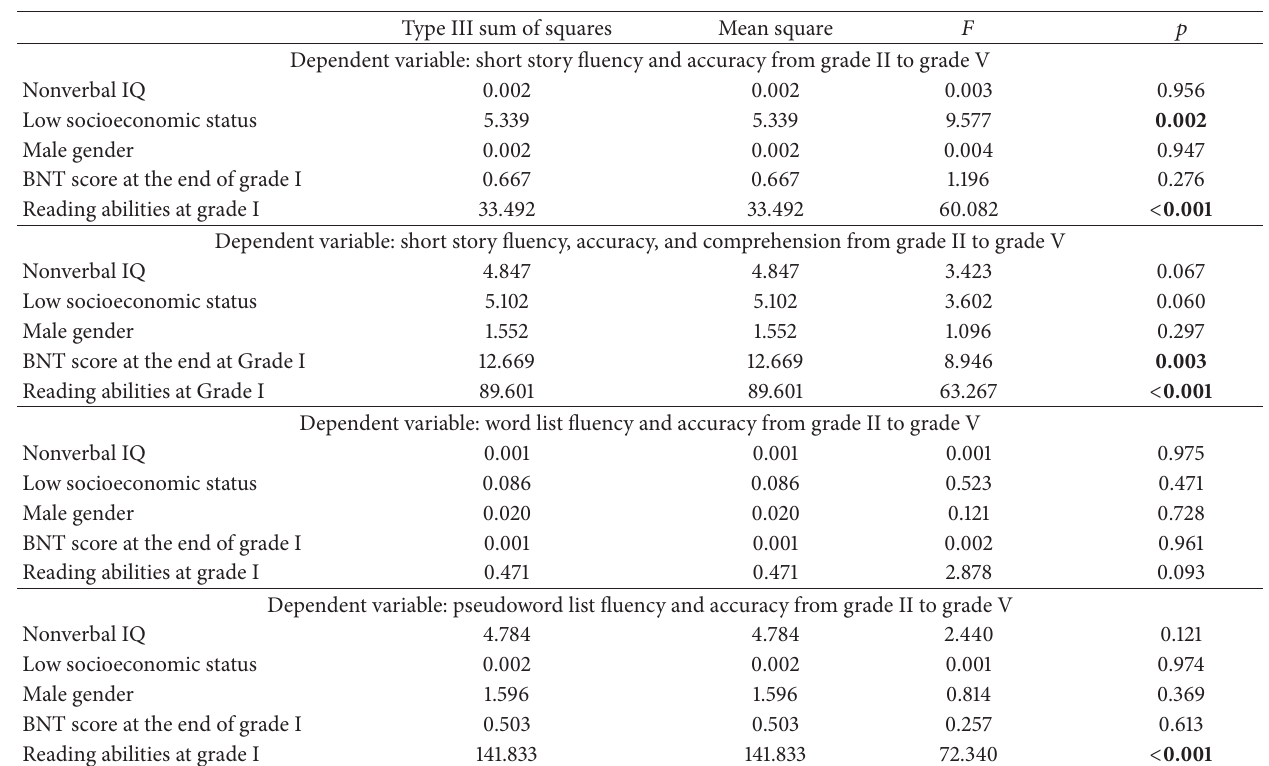
Table 7: Variables associated with reading abilities improvement from grade II to grade V, in four multivariate general linear models with repeated measures (longitudinal